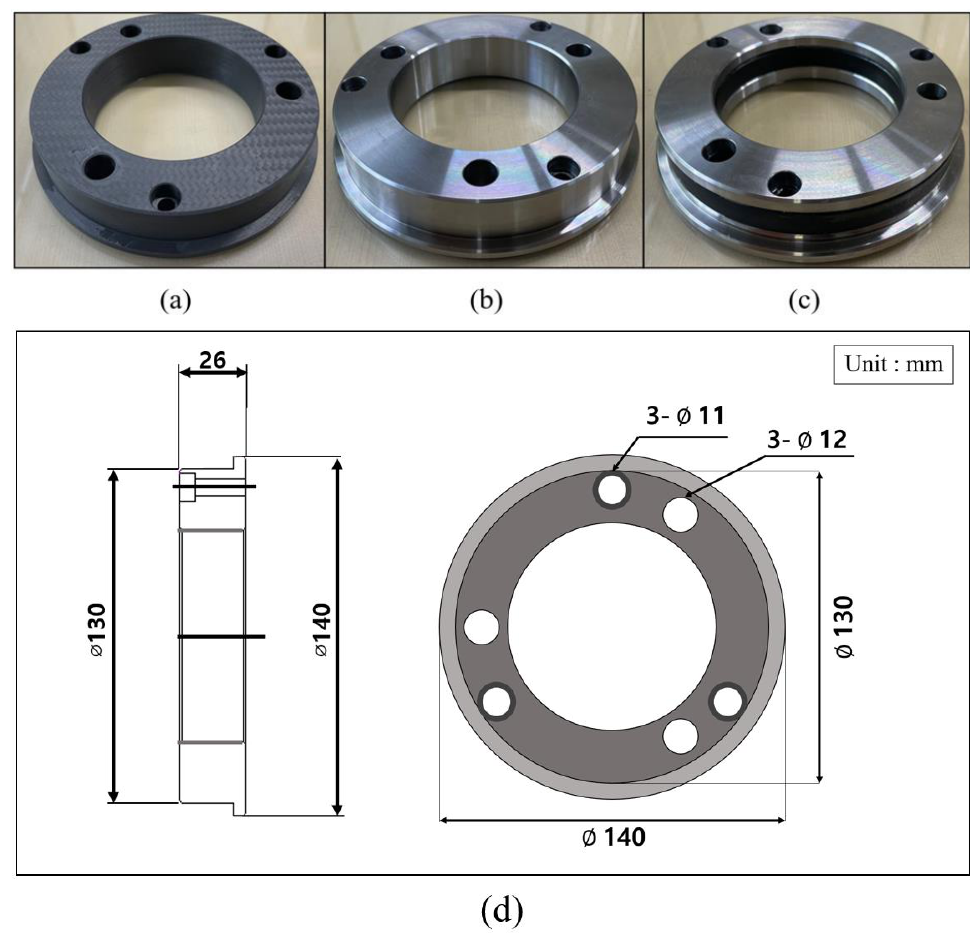
Figure 3. Photographs and drawing of chuck adapter. ( a ) CFRP, ( b ) steel, ( c ) CFRP with steel, and ( d ) drawing.